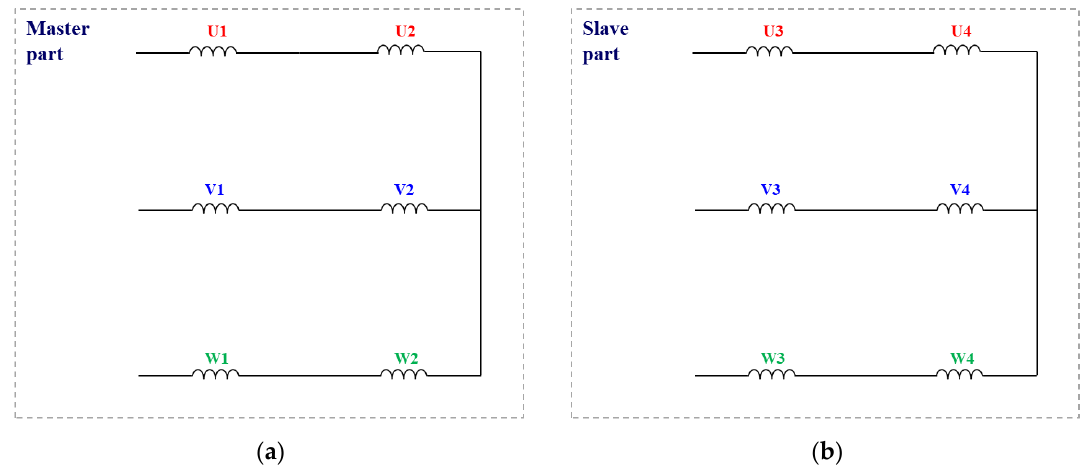
Figure 6. Winding topologies of conventional DWM: ( a ) Master part; ( b ) Slave part.